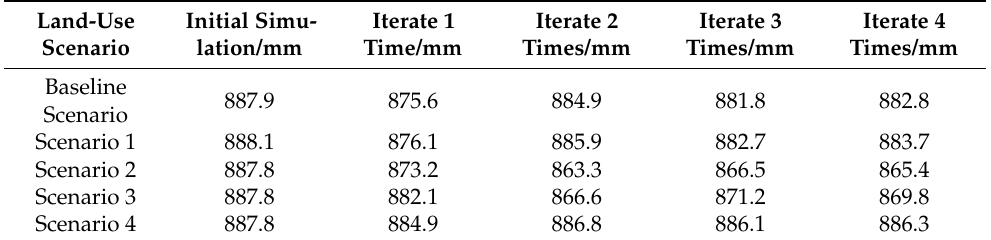
Table 7. Annual potential evaporation in multiple iterations in each scenario.